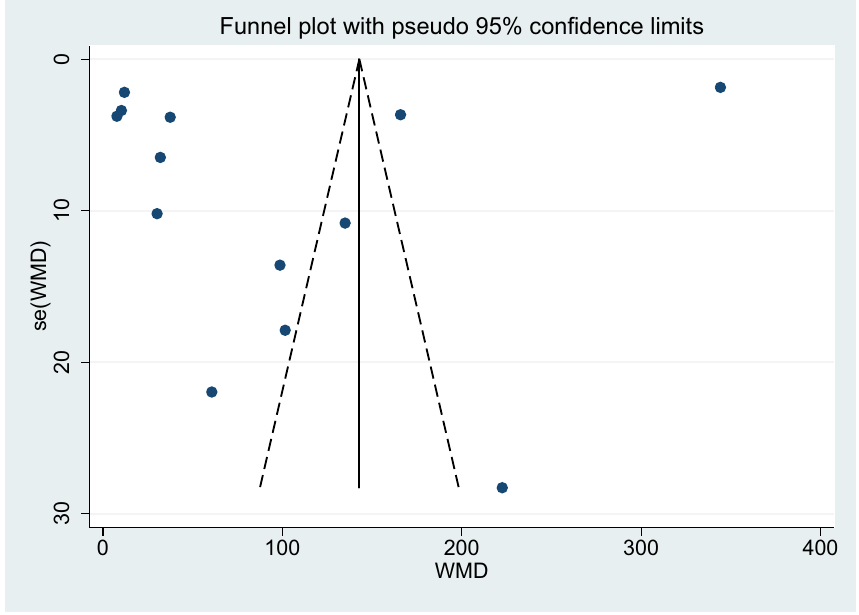
Figure 16. Funnel plot demonstrating the distribution of the effect size (WMD) and standard error of the effect size (seES) among studies included in the meta-analysis of severe and non-severe malaria.